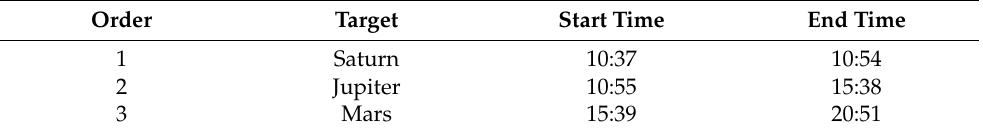
Figure 7. Air masses of the targets. Solid lines represent the targets’ airmass. Shaded areas indicate the observable time of each target. Vertical dashed pink, blue, and green lines indicate the civil, nautical, and astronomical twilight ( − 6°, − 12° and − 18°), respectively. Unobservable targets during this time span are not shown.